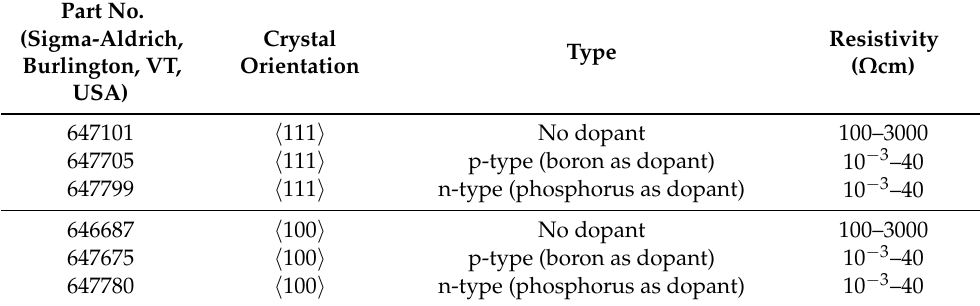
Table 1. Silicon